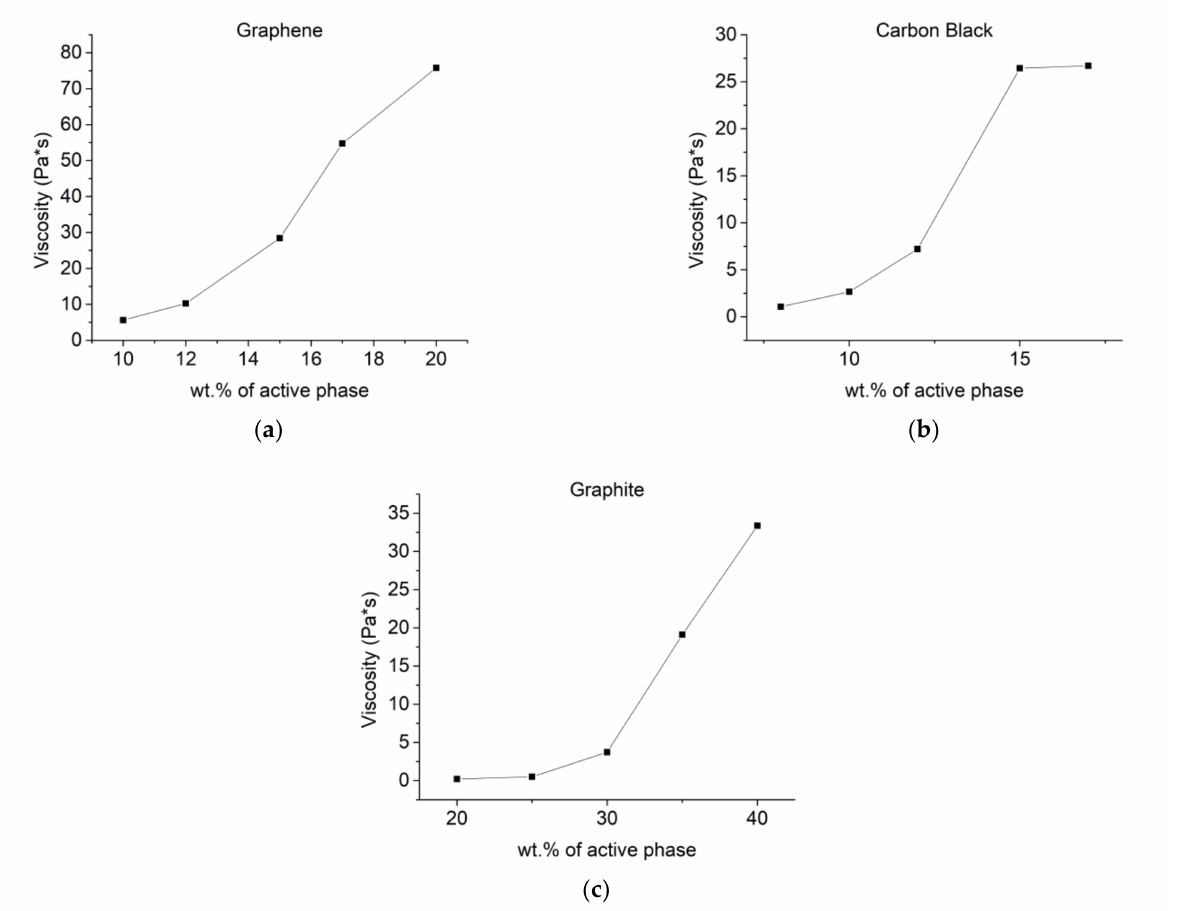
Figure 2. Rheological measurements of prepared composites displaying the relationship between wt.% of active phase and viscosity with the shear rate of 50 1/s for composites based on: ( a ) Graphene; ( b ) Carbon black; ( c ) Graphite.